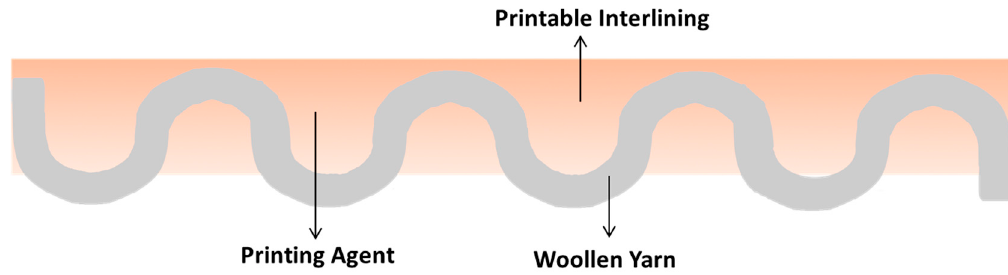
Figure 19. Printable interlining (Reproduced from Reference [117] with permission from Springer Nature and Copyright Clearance Center, 2018).